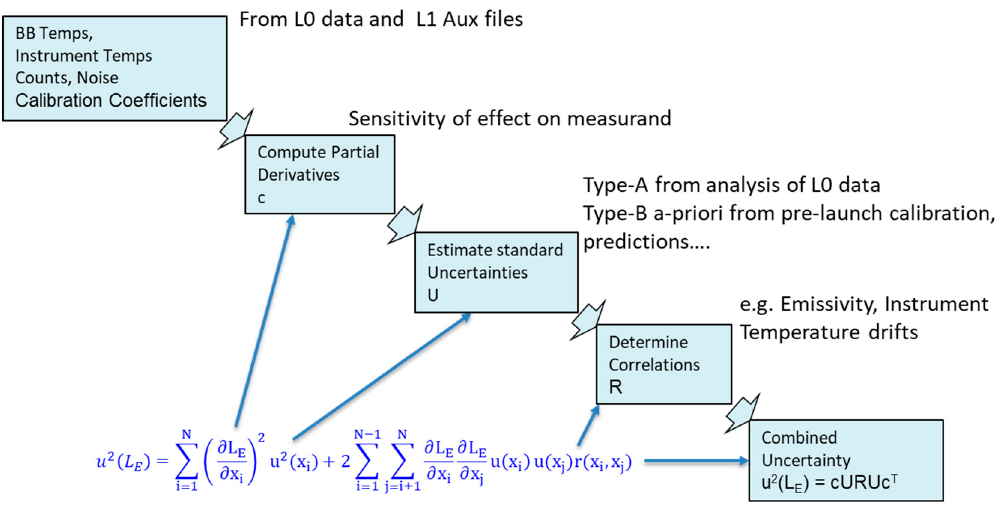
Figure 2. Derivation of SLSTR L1 radiometric uncertainties.